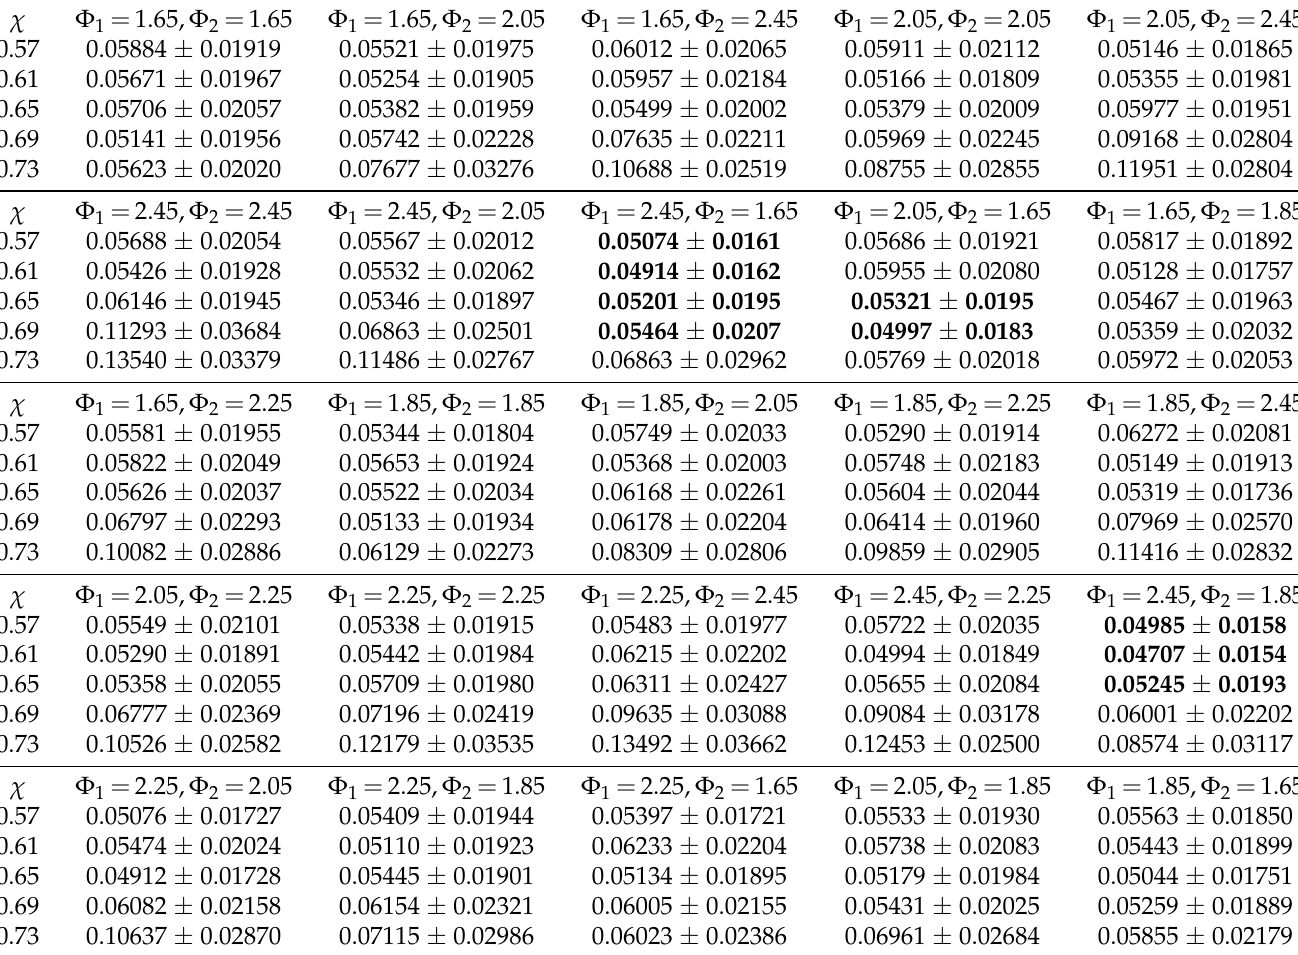
Table 6. The values of mean and standard deviation of f 4 obtained using PSO with I = 100, D = 80, (cid:96) = 12, n = 25 for 50 calculations with the metric d 3